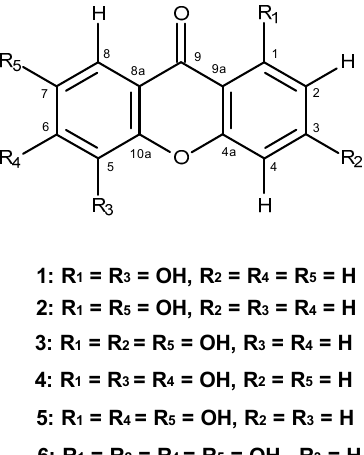
Figure 1. Polyhydroxylated xanthones from G. succifolia